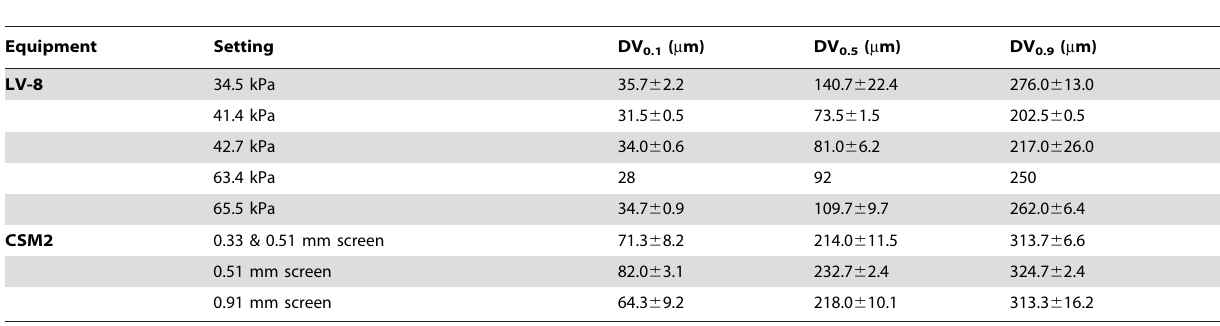
Table 1. Droplet spectra for VectoBac WDG determined by 2-D phase doppler particle analyzer 6 SEM.*